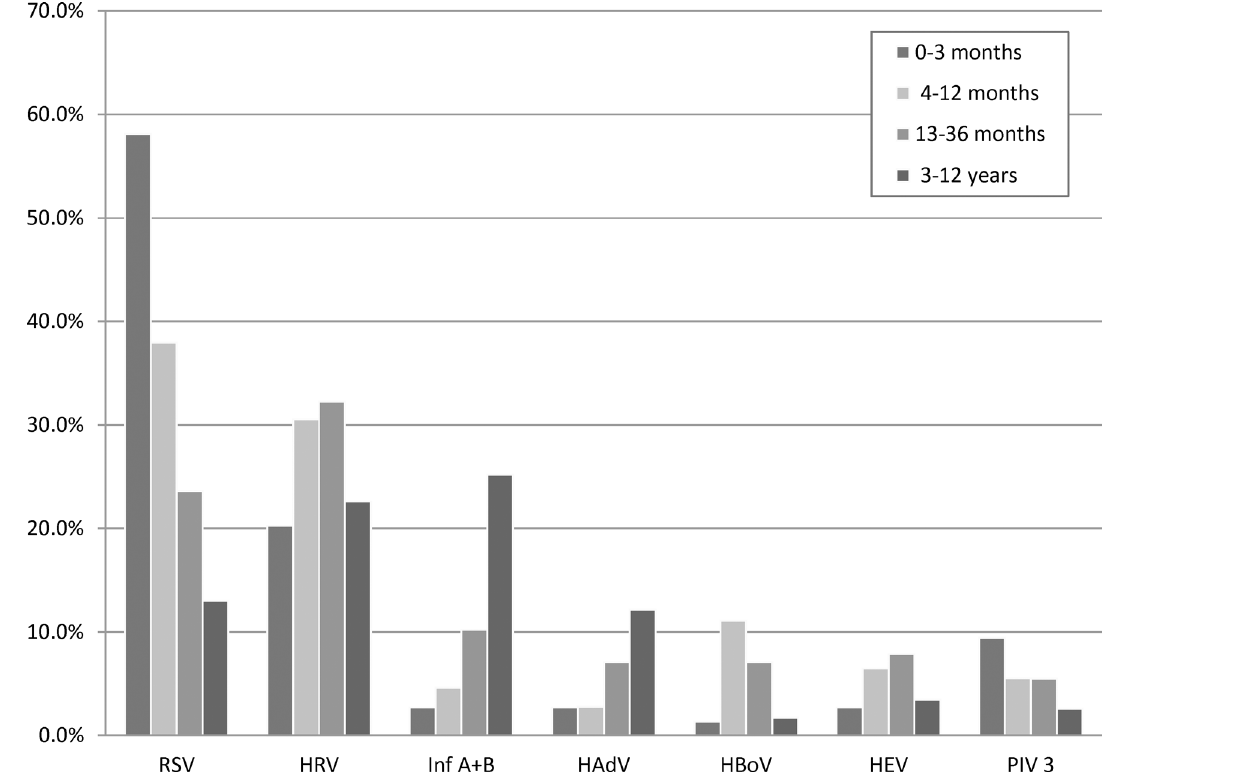
Fig 3. Distribution of virus infection by patient age for the 7 most frequently detected